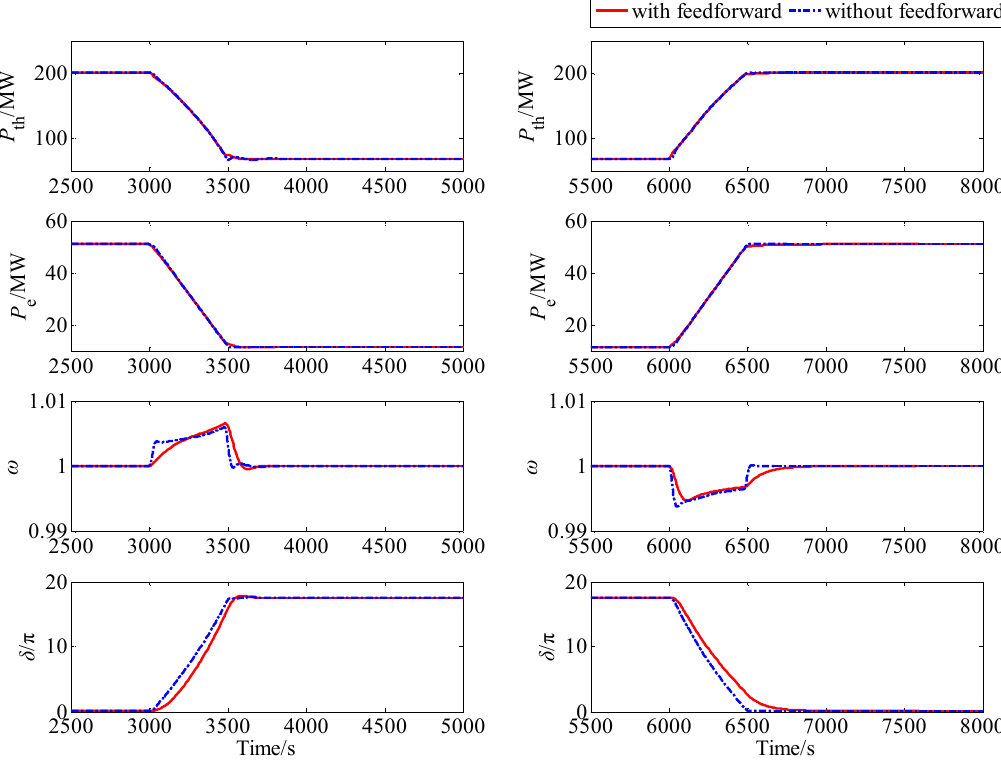
Figure 9. Responses of electric variables in the case of load maneuvering, P th : thermal power, P e : electric power, ω : normalized frequency, and δ : phase angle.